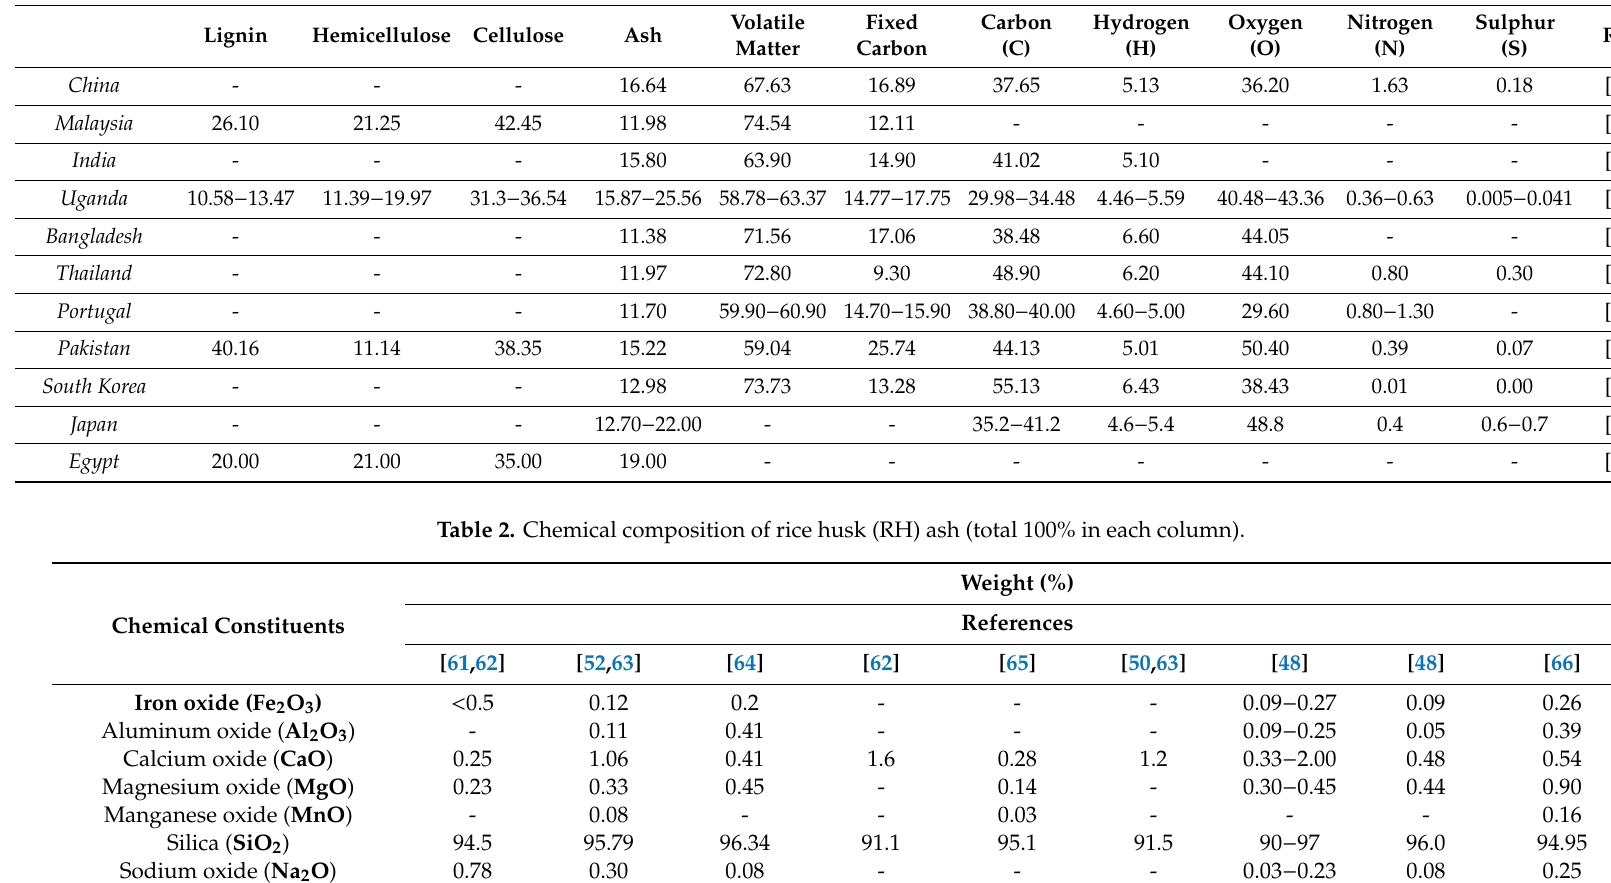
Table 1. Physicochemical and biochemical properties of rice husk (RH) based on geographical location of growth (dry basis). Geographical